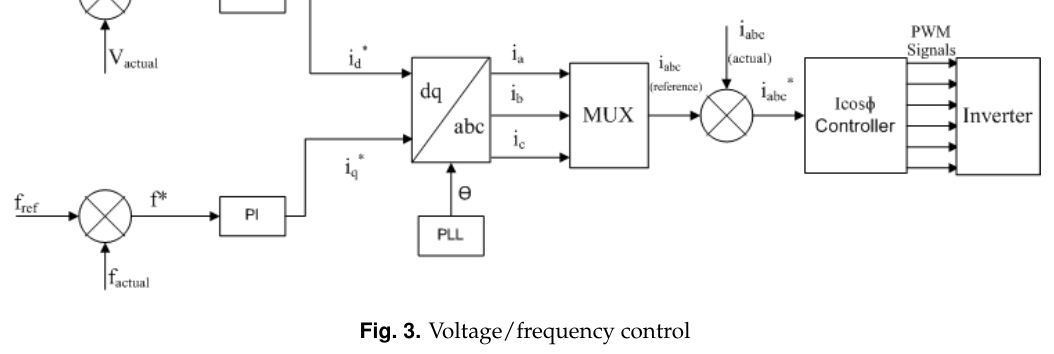
Fig. 3. Voltage/frequency control